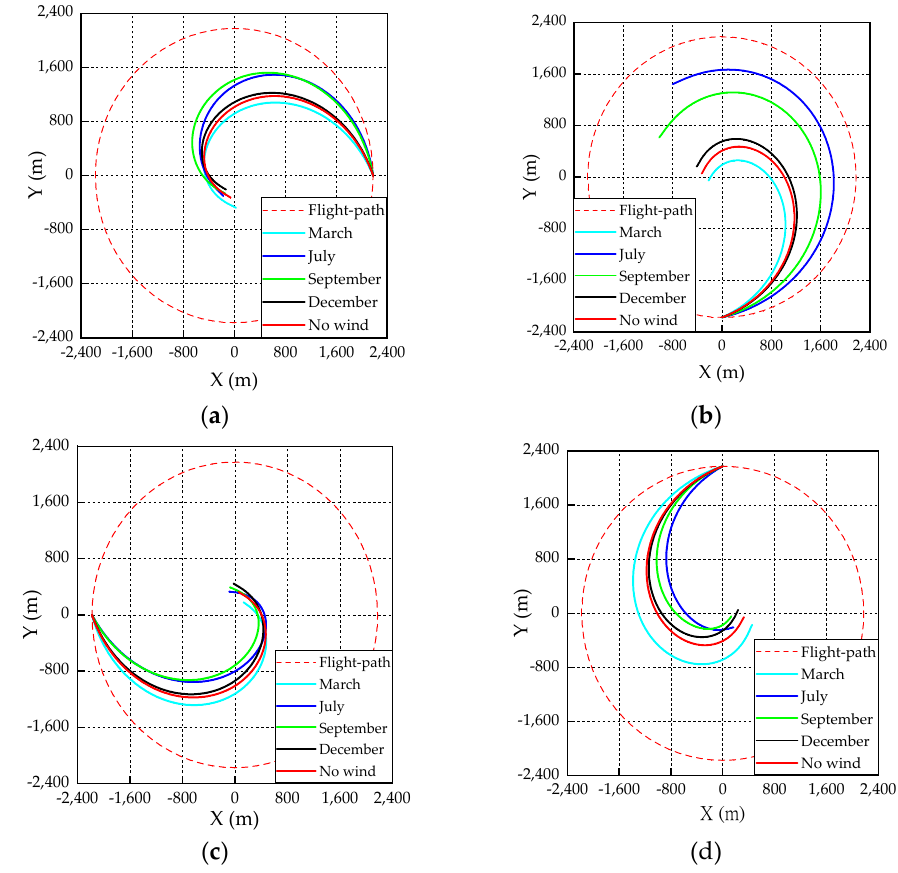
Figure 21. Vertical view of towline spatial configuration with different phase of the flight: ( a ) phase = 0°; ( b ) phase = − 90°; ( c ) phase = − 180°; ( d ) phase = − 270°.